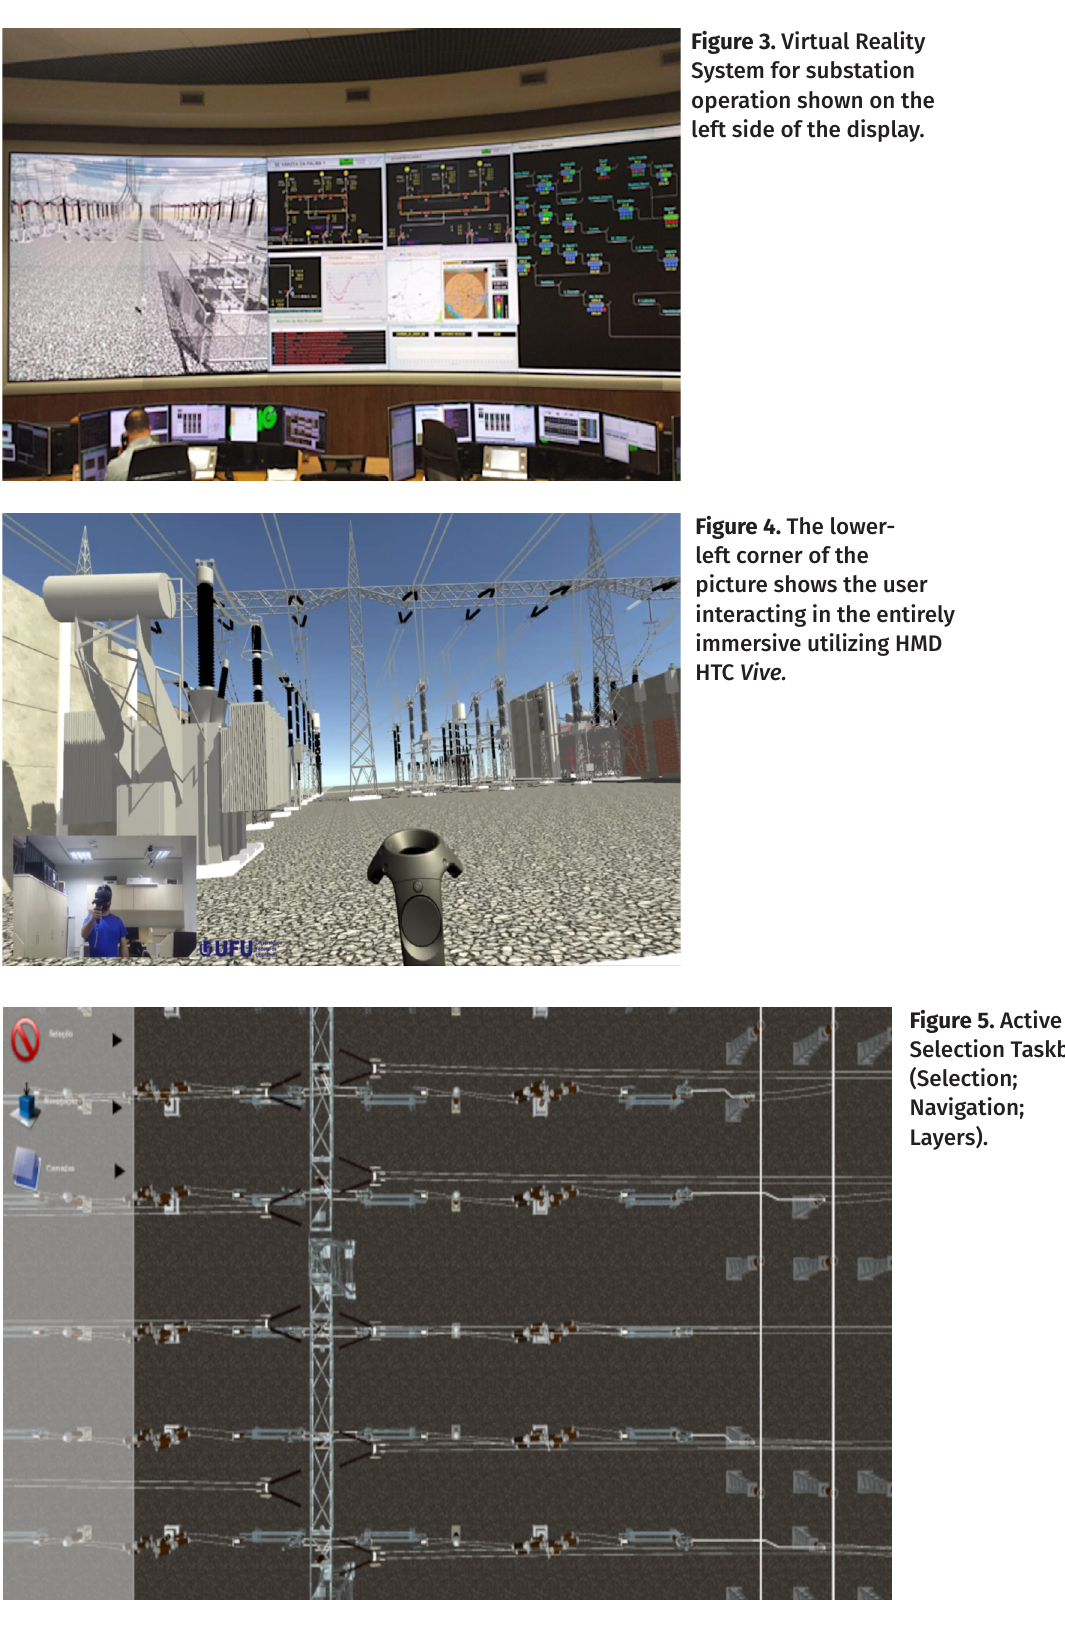
Figure 3. Virtual Reality System for substation operation shown on the left side of the display.